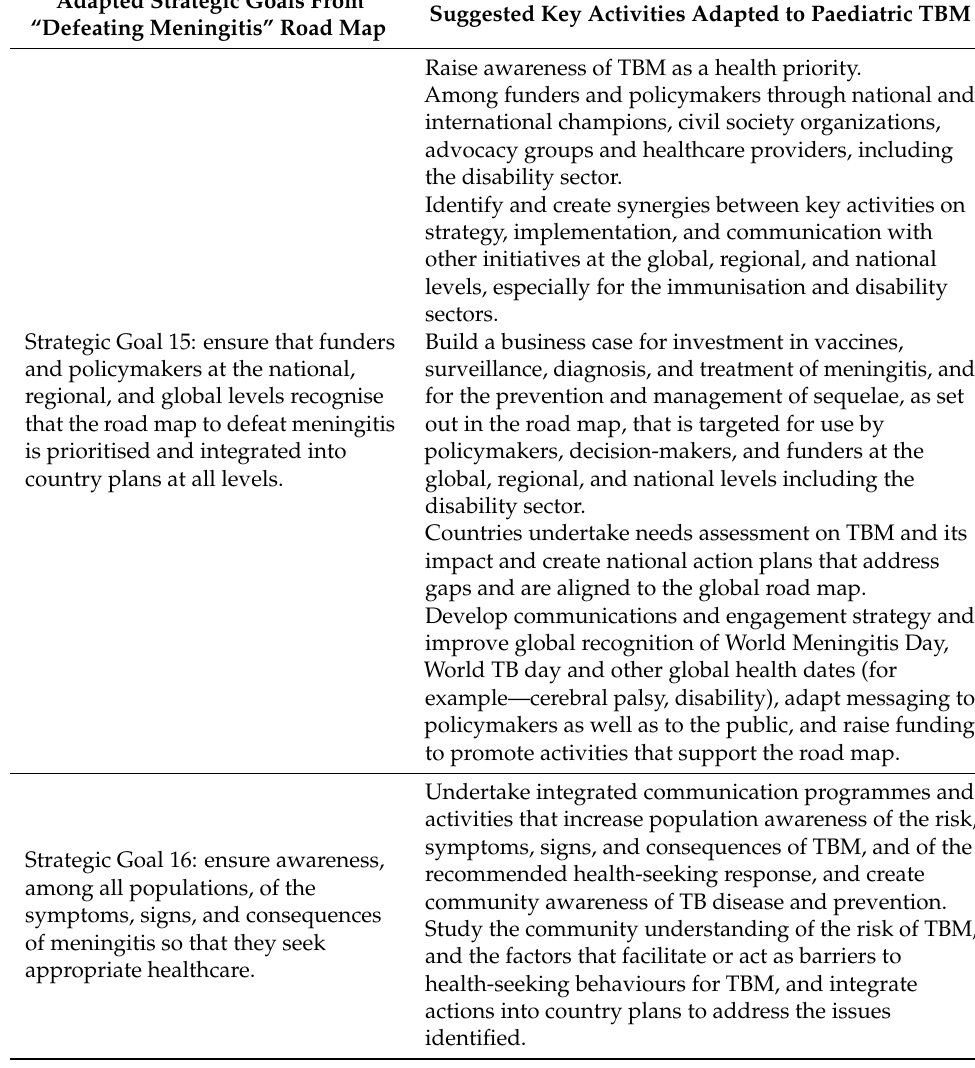
Table 6. Selected relevant strategic goals reproduced from Pillar 5 the “defeating meningitis” roadmap and suggested paediatric TBM-related activities